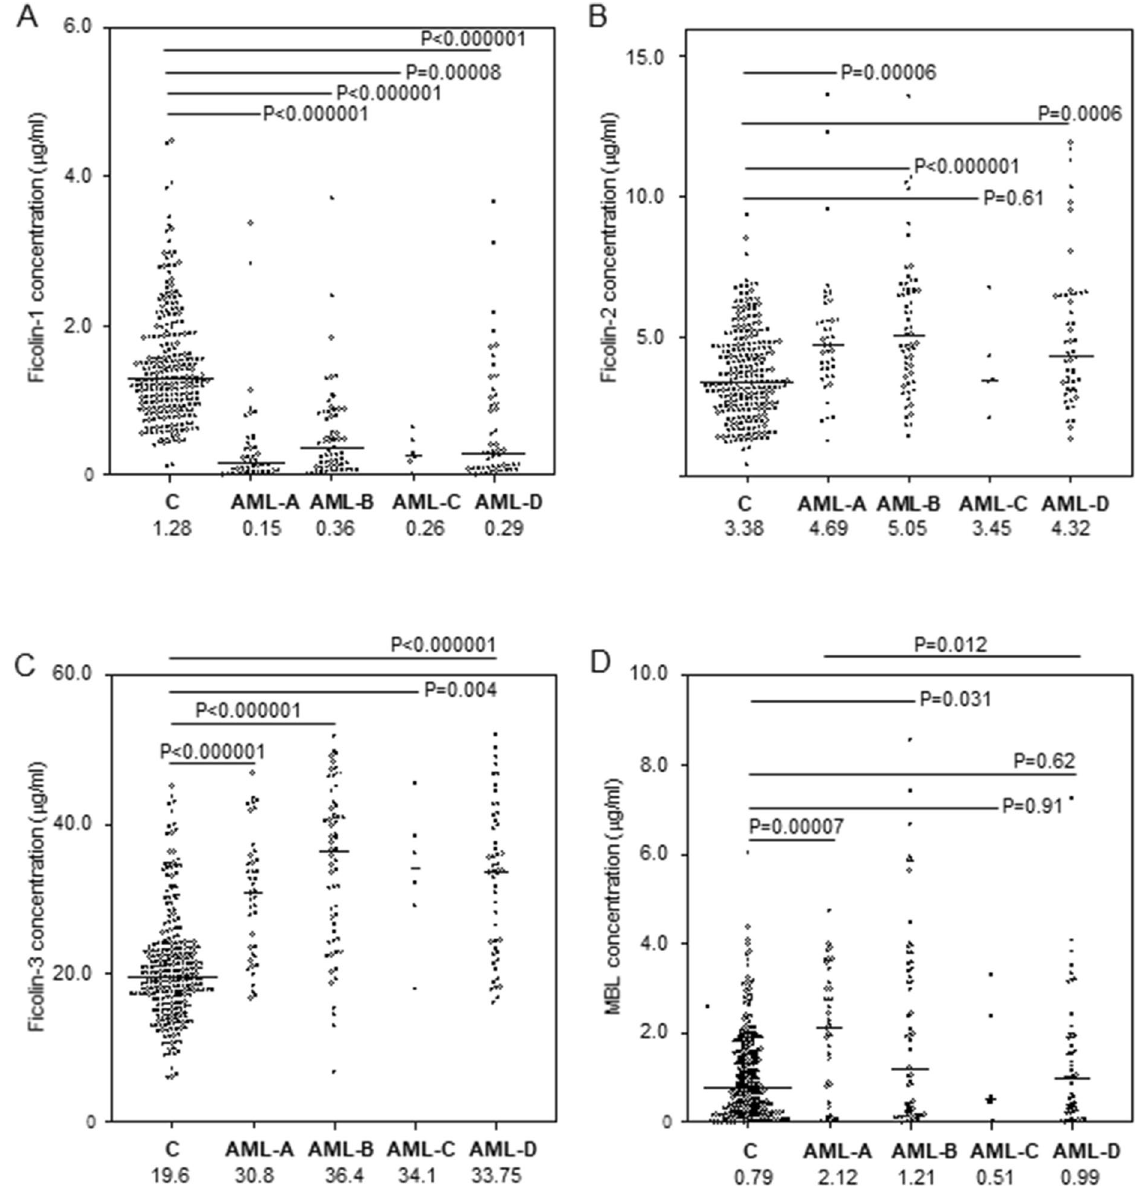
Figure 1. Serum concentrations of ficolin-1 ( A ), ficolin-2 ( B ), ficolin-3 ( C ) and mannose-binding lectin ( D ) in patients (before chemotherapy) and controls. Bars present median values (given below group descriptions). C: controls; AML-A: patients who experienced infections with proven bacteremia and/or fungaemia; AML-B: patients who experienced infections with no bacteremia; AML-C: patients who experienced febrile neutropenia; AML-D: patients who experienced none of afore-mentioned complications within 4 weeks of hospital stay. The medians of protein concentrations were compared using the Mann–Whitney U